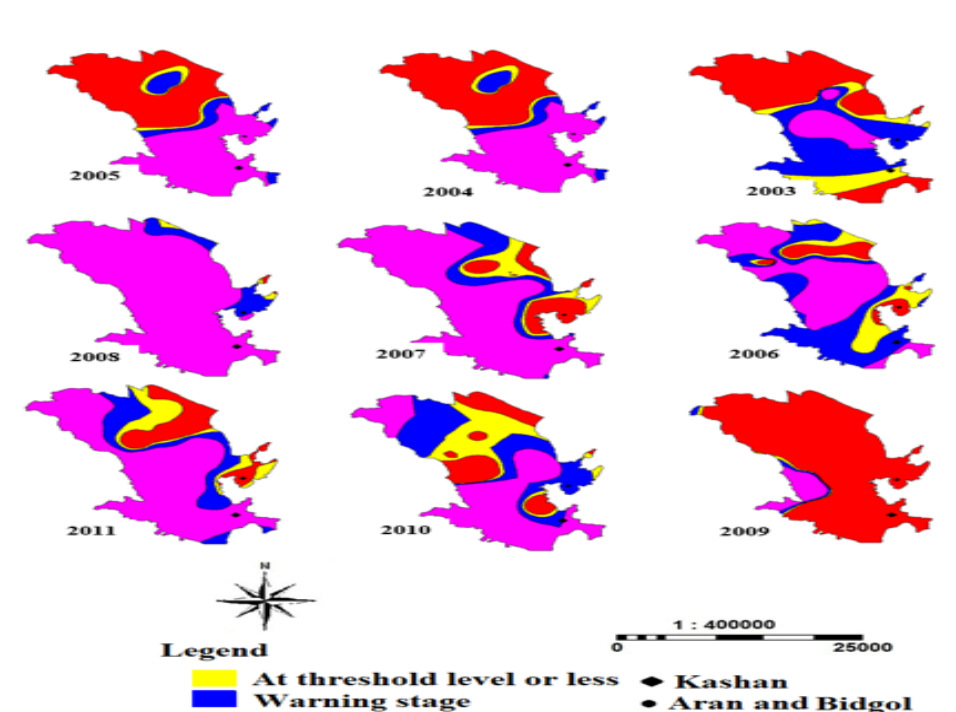
Figure 4. Map of desertification class based on groundwater drop during